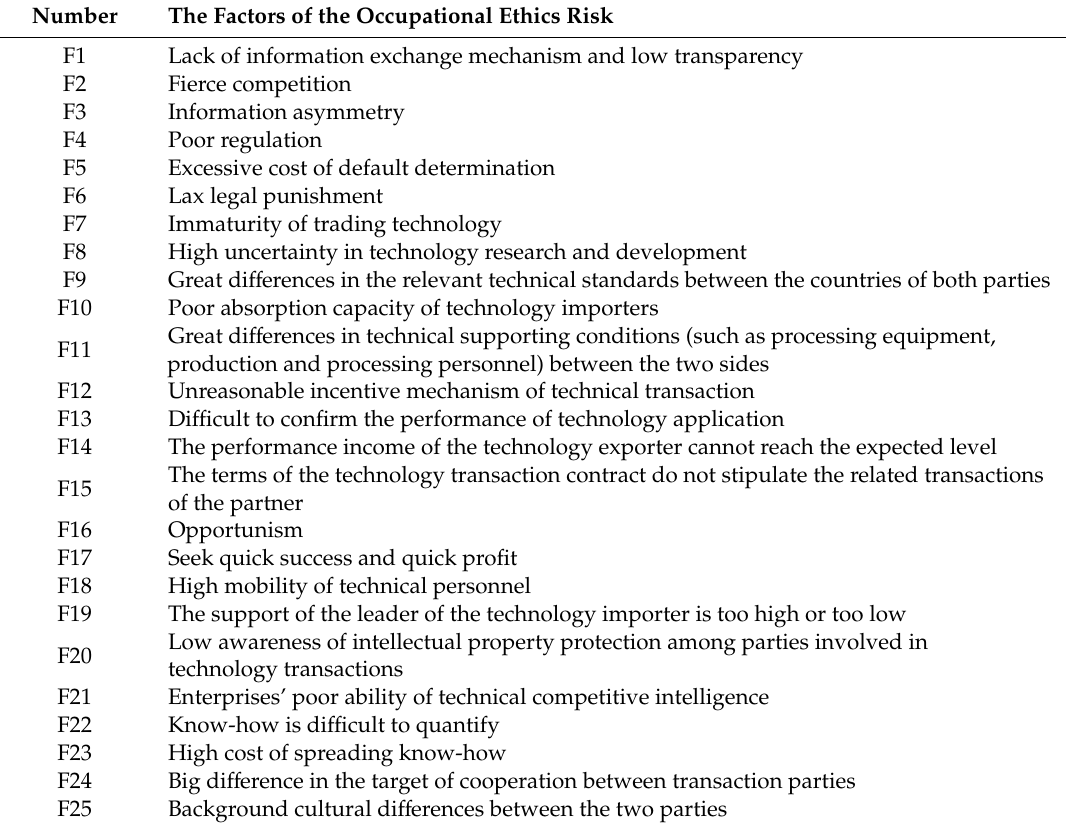
Table 1. Factors that trigger occupational ethics risk in engineering technology